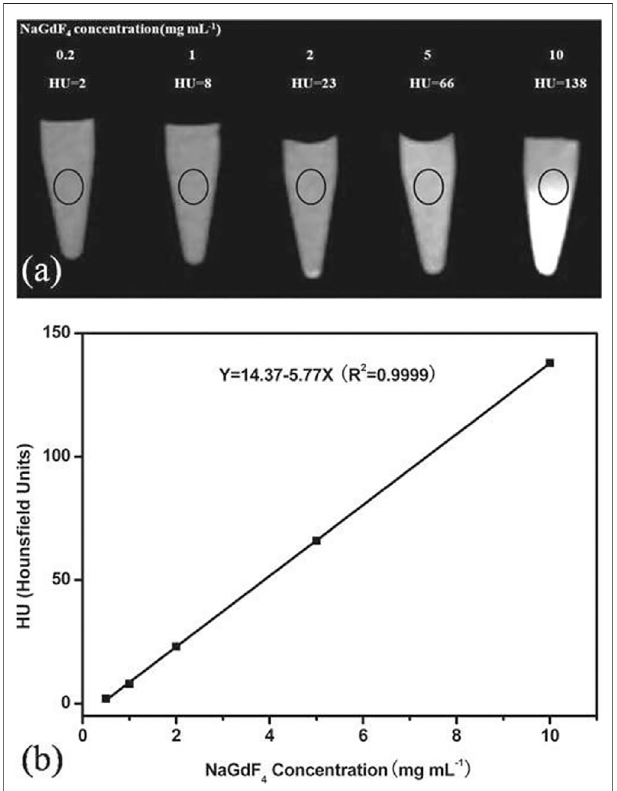
FIGURE 11 | (A) In vitro CT images of lanthanide-doped NaGdF 4 upconversionnanocrystalssuspendedinPBS.Theconcentration(mgml − 1 )in each sample is provided at the top of the respective images. (B) CT attenuation (HU) of lanthanide-doped NaGdF 4 upconversion nanocrystals at various concentrations (He et al., 2011a).